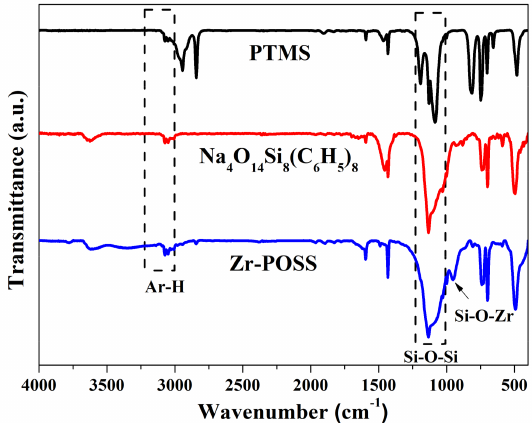
Figure 2. FTIR spectra of PTMS, Na 4 O 14 Si 8 (C 6 H 5 ) 8 and